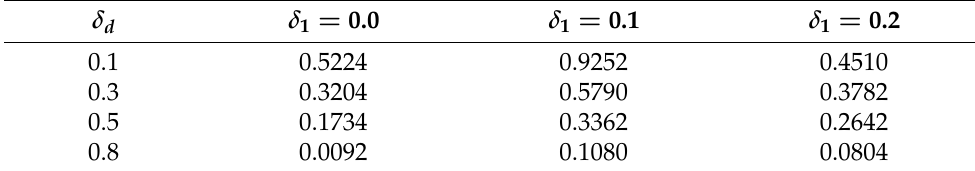
Table 2. The maximum upper bound of ρ for different δ d and various δ 1